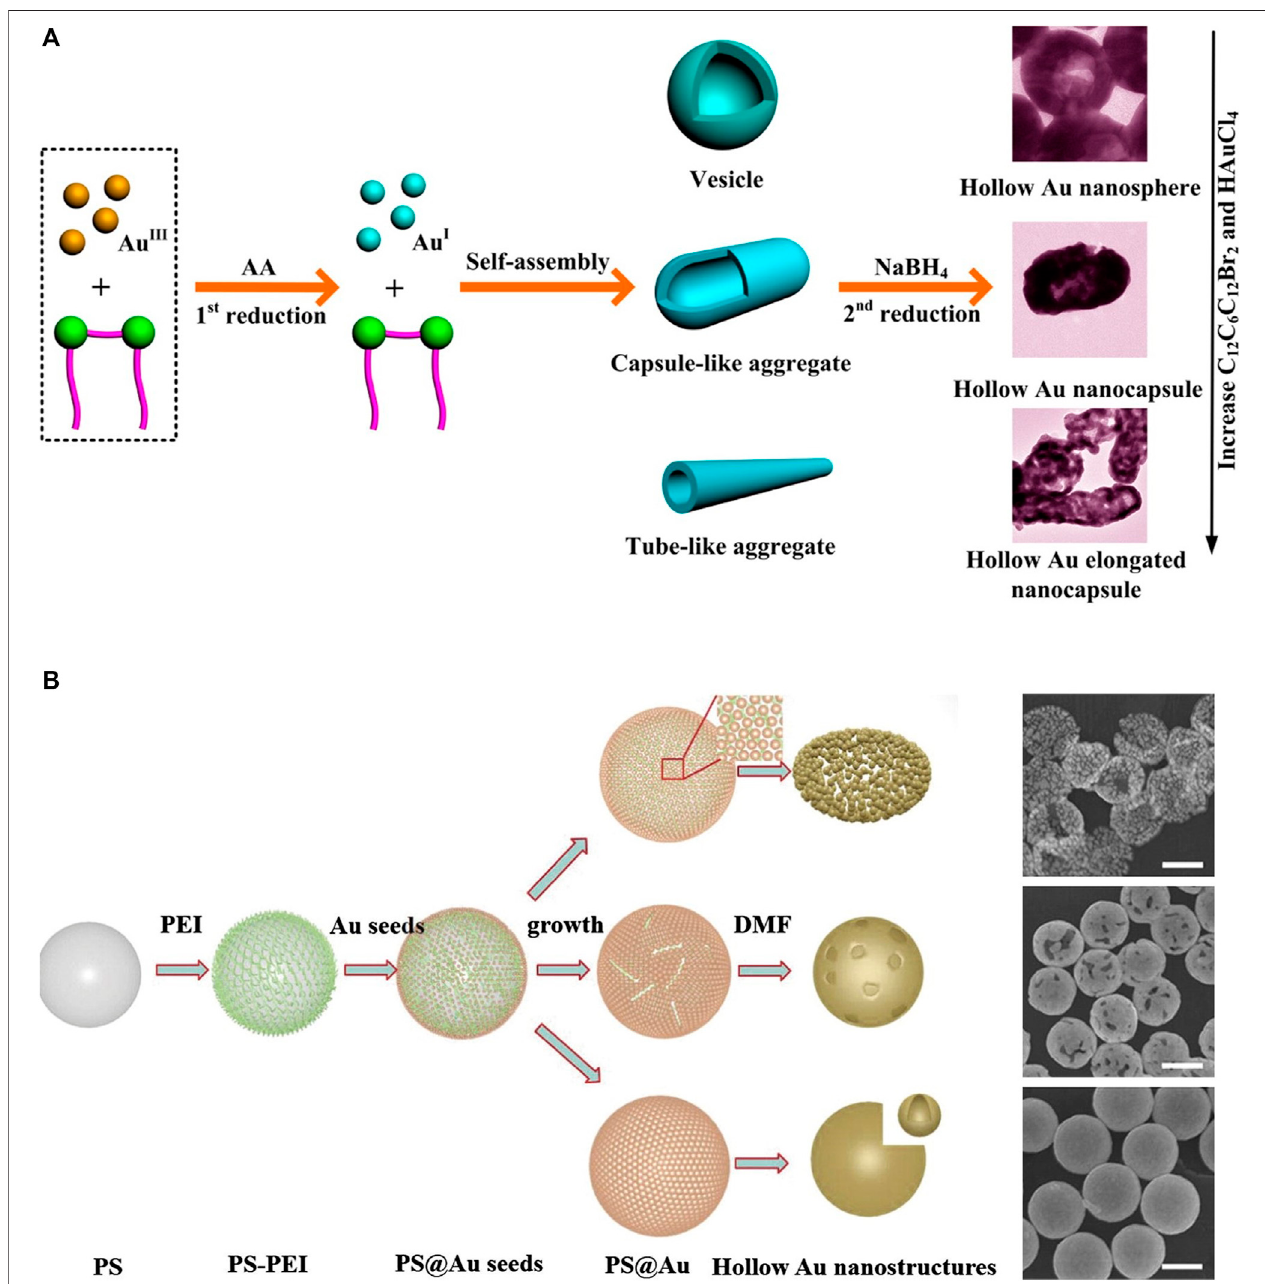
FIGURE 6 | Schematic illustration of the synthesis of hollow gold nanostructures based on non-galvanic replacement method and its transmission electron microscopy (TEM) images. (A) Hollow gold nanostructure synthesis using the stepwise reduction method. (B) Hollow gold nanostructures from polystyrene (PS)@Au core – shell nanospheres, scale bar: 200 nm. (A) Reprinted with permission from Wang et al. (2013). Copyright 2013, American Chemical Society. (B) Reprinted with permission from Wang H. et al. (2015). Copyright 2014, Elsevier.